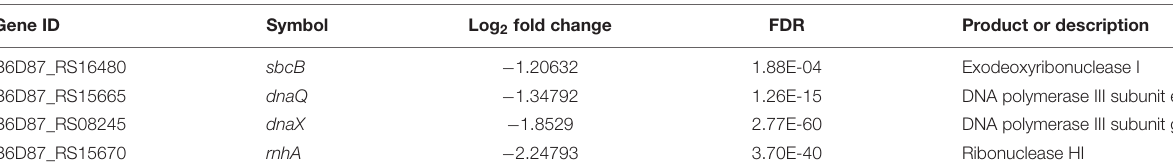
TABLE 3 | Differentially expressed genes related to DNA replication and repair.